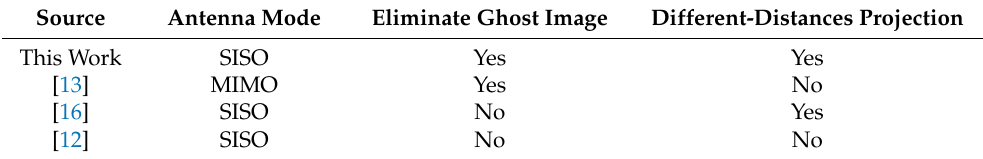
Table 1. Compared to some related